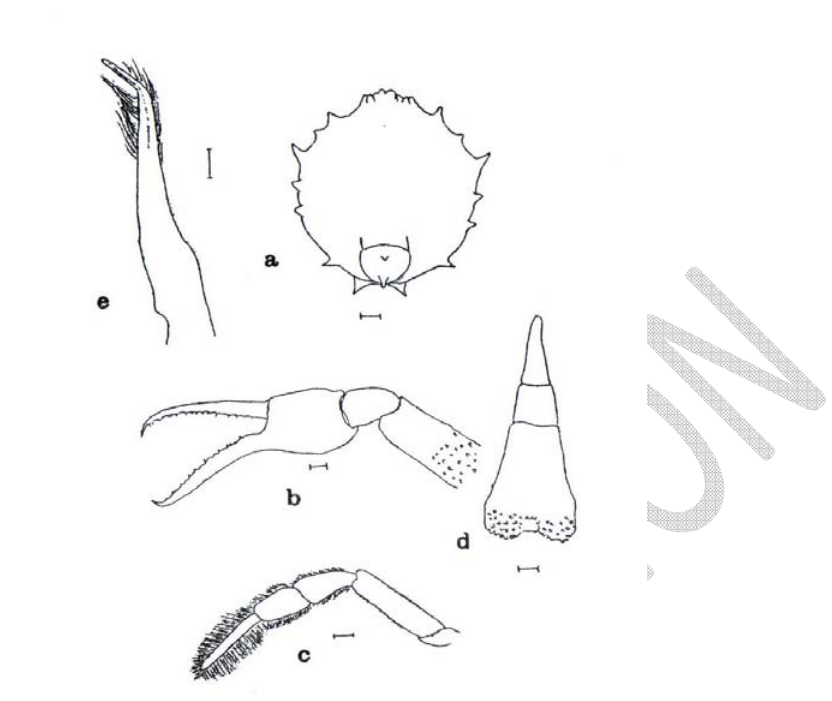
6._ Pariphiculus mariannae (Herklots, 1852): a, carapace; b, cheliped; c, left F IG . last walking leg; d, male abdomen; e, first gonopod. Scales: a, b, c and d, 1 cm; e, 1 mm . Subfamily LEUCOSIINAE Samouelle, 1819 Genus Seulocia Galil, 2005b 7- Seulocia anahita Galil, 2005b (Fig.